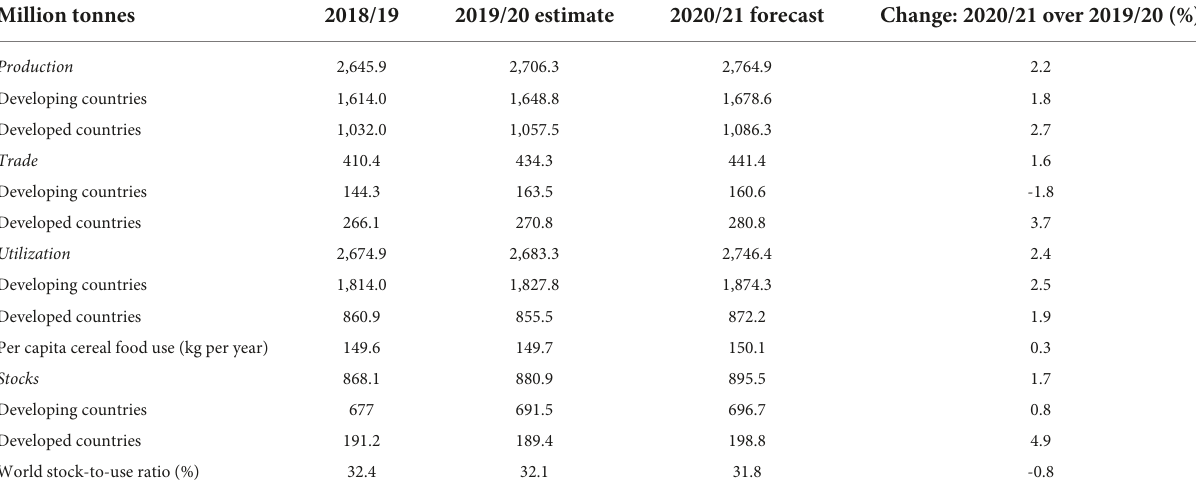
TABLE 1 Basic facts of world cereal